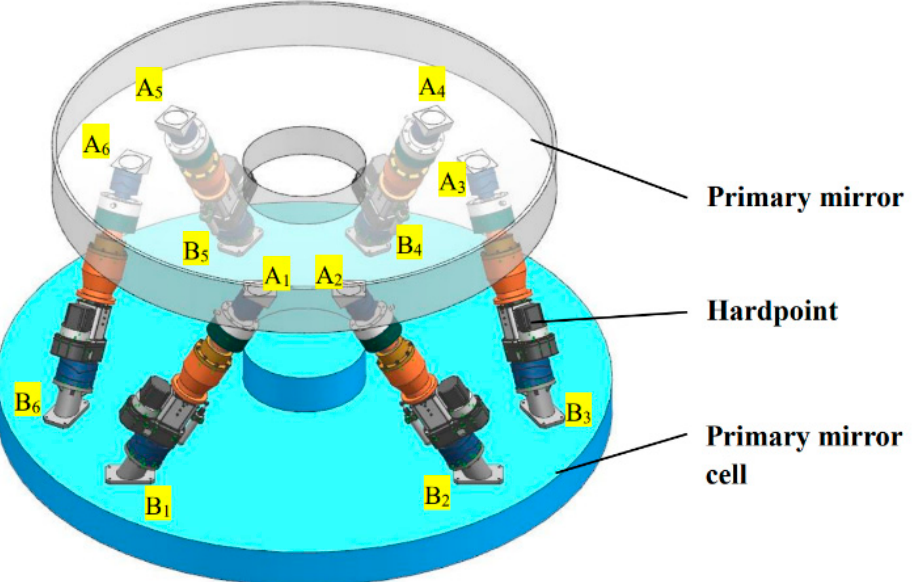
Figure 1. Three-dimensional model of the six-hardpoint positioning mechanism and the primary mirror positioning system. For clarity of expression, the primary mirror has been changed to translucent, and the structure of the mirror cell has been simpli fi ed.